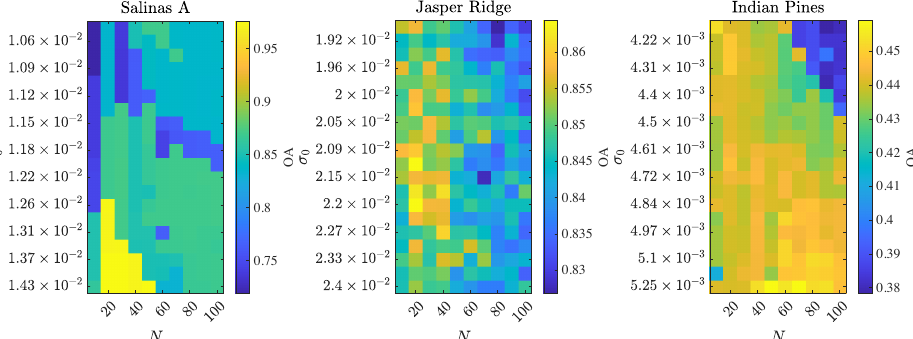
Figure 8. Visualization of D-VIC’s median OA across 50 trials as hyperparameters N and σ 0 are varied. D-VIC achieves high performance across a large set of